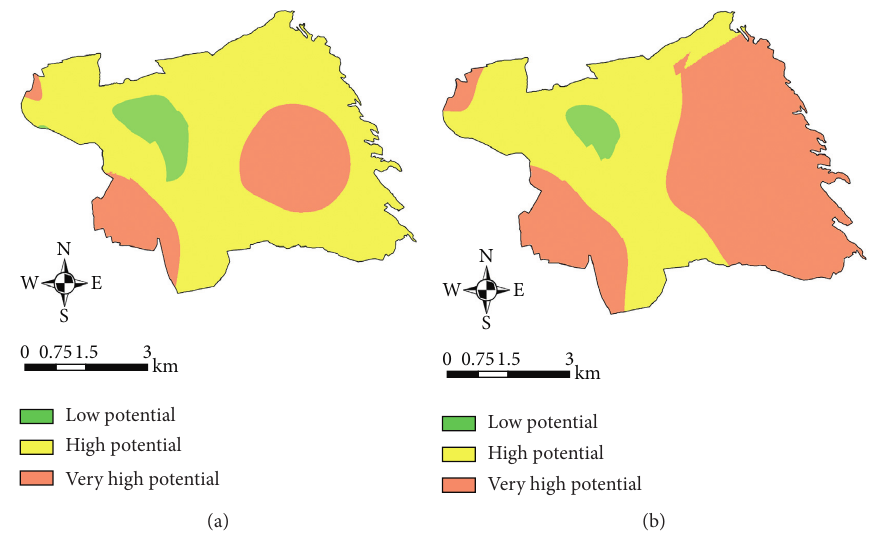
Figure 8: Liquefaction potential level at 475-year return period. (a) Pseudo-probabilistic approach and (b) PLHA.